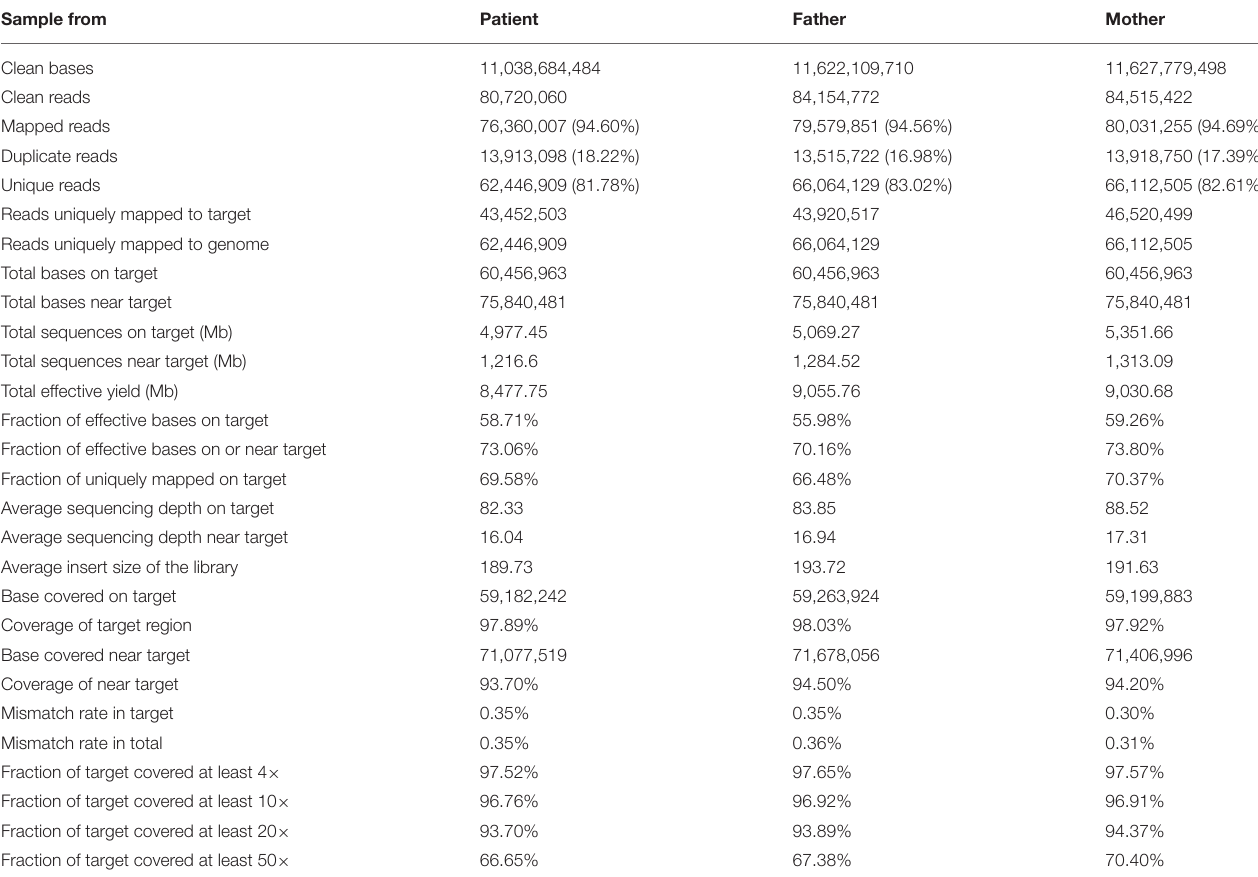
TABLE 2 | Quality control results compared with reference human genome. Sample